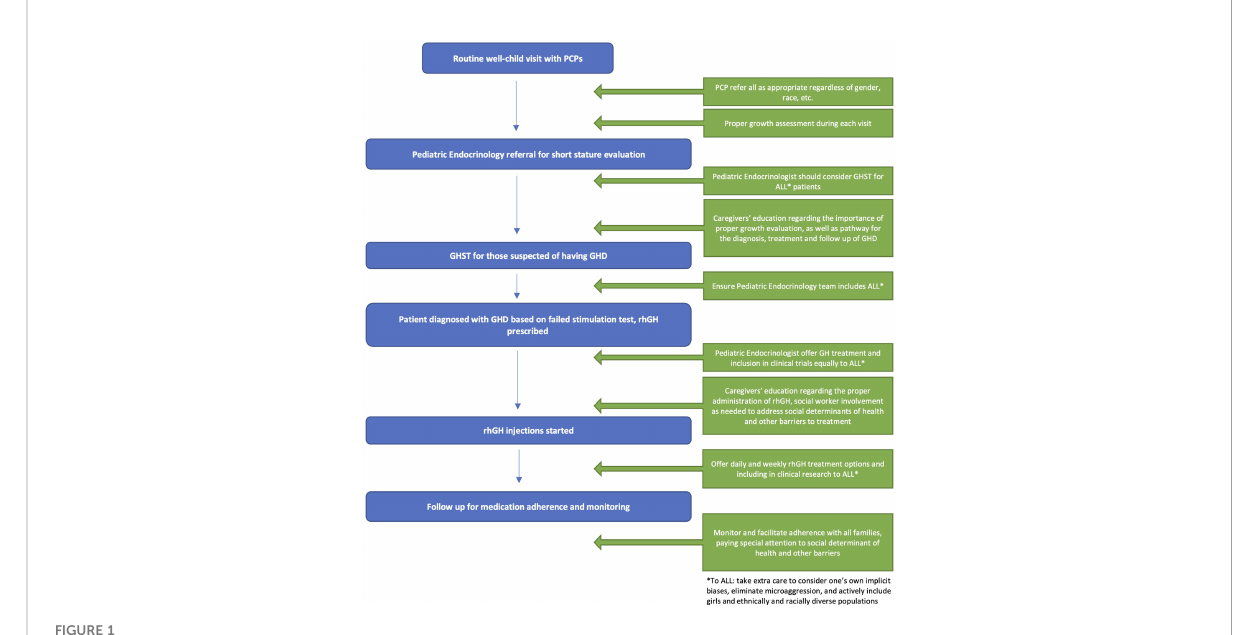
FIGURE 1 Proposed